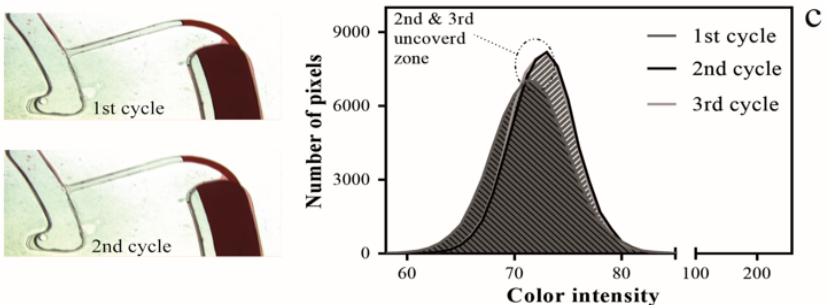
Figure 5. The color intensity histogram of mixing a colorless and dark red dyed DI water; ( a ) the color intensity of the DI water used in the experiment; ( b ) the color intensity of the liquids inside the mixing chamber before mixing; ( c ) the color intensity of the mixed liquid after first, second and third cycle. Specific regions of the obtained digital images of the pipetted and mixed liquids were